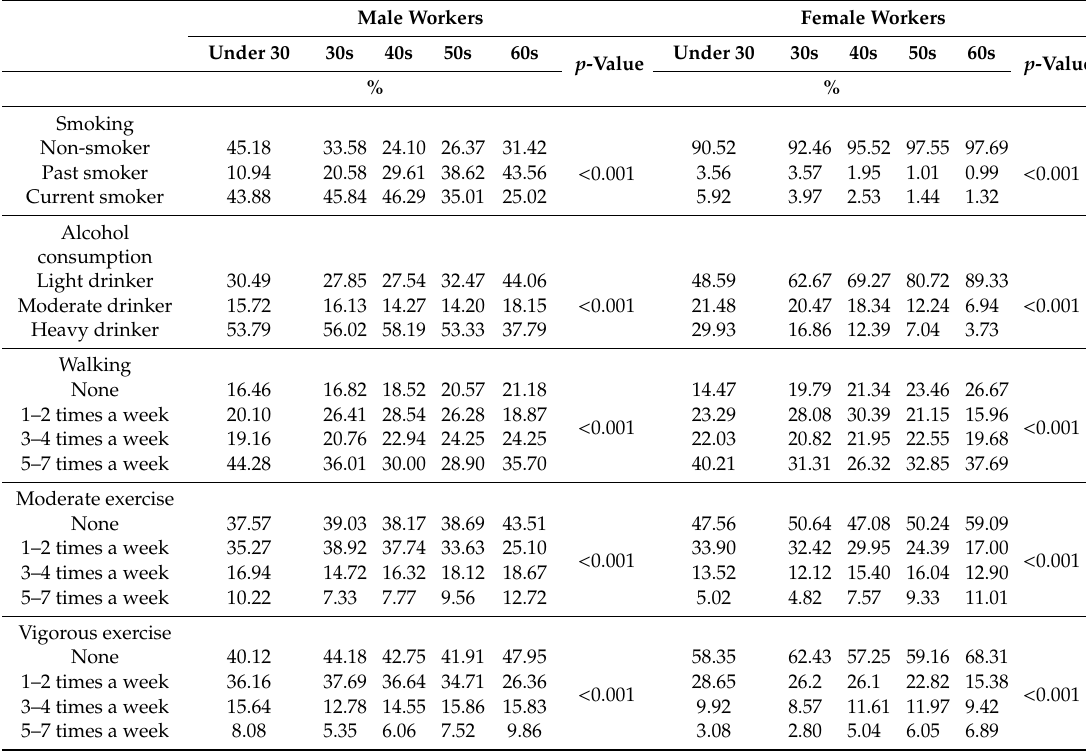
Table 2. Sex di ff erences of health behavior by age.